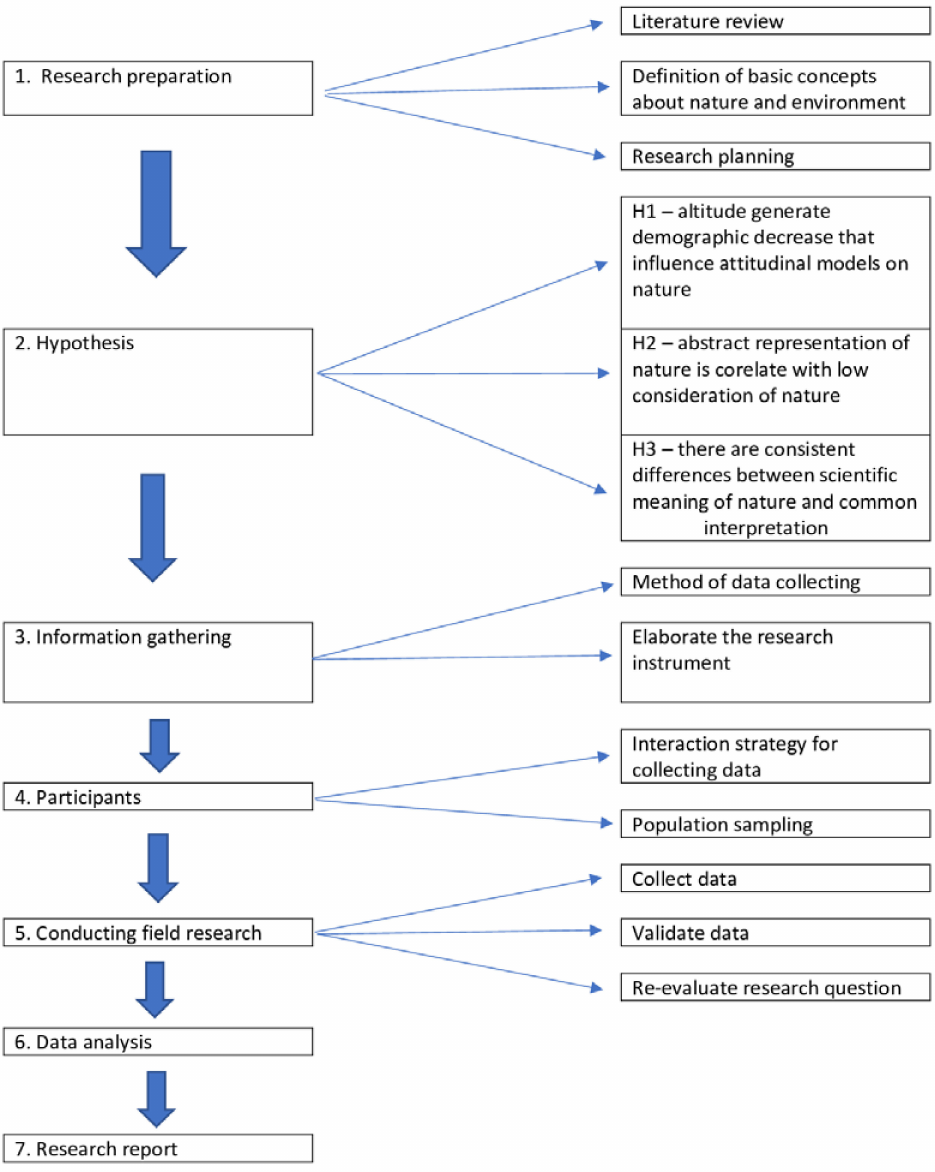
Figure 2. Diagram of the research